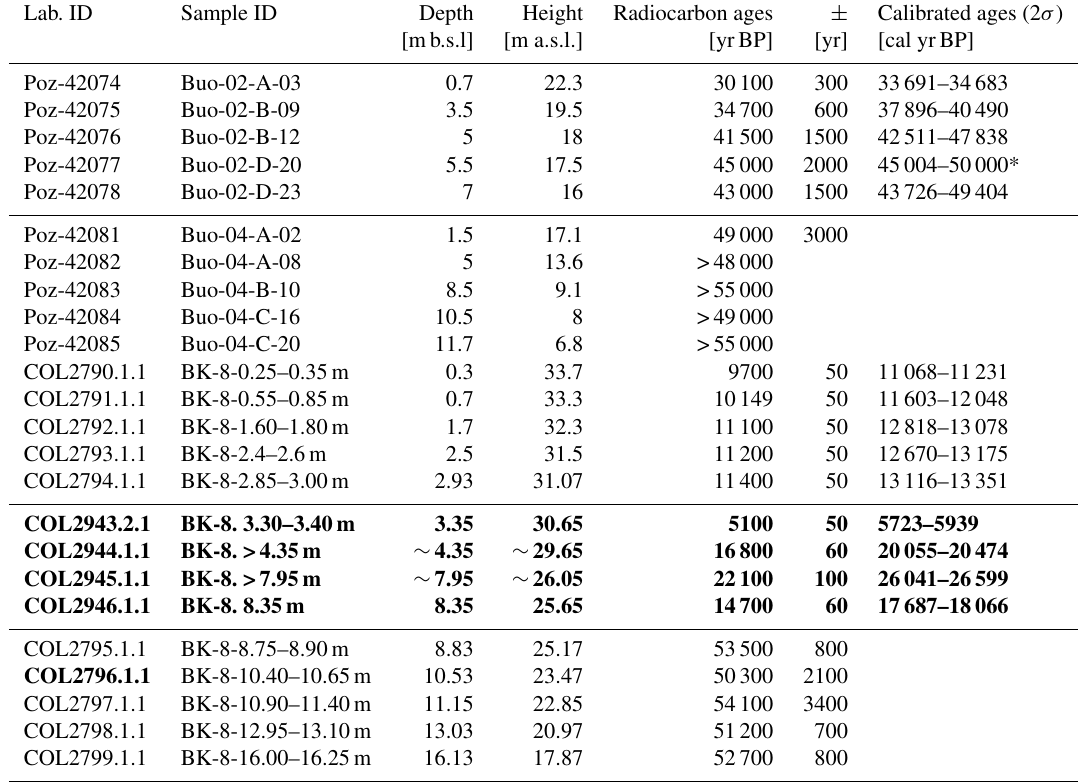
Table 2. Radiocarbon dating on plant macro remains (and two sediment samples containing plant remains: COL2945 and COL2796). Cali- brations were done using Calib 7.0.2 and the IntCal13 curve (Reimer et al., 2013). Ranges marked with a * are suspect due to impingement on the end of the calibration data set. Depth is given in metres below surface level (mb.s.l.) and height in metres above sea level (m a.s.l.). Poz: Poznan Radiocarbon Laboratory, Poland; COL: CologneAMS, Germany. The bold marked samples are from the ice wedge in BK-8. Lab. ID Sample ID Depth Height